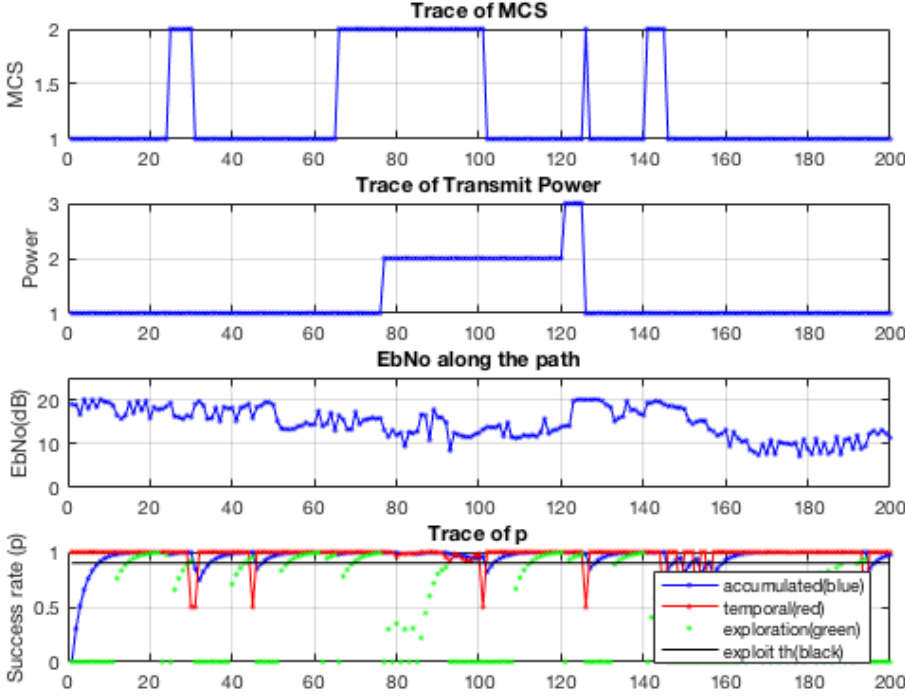
Figure 11. Simulation results indicating the behavior of the Learner in different